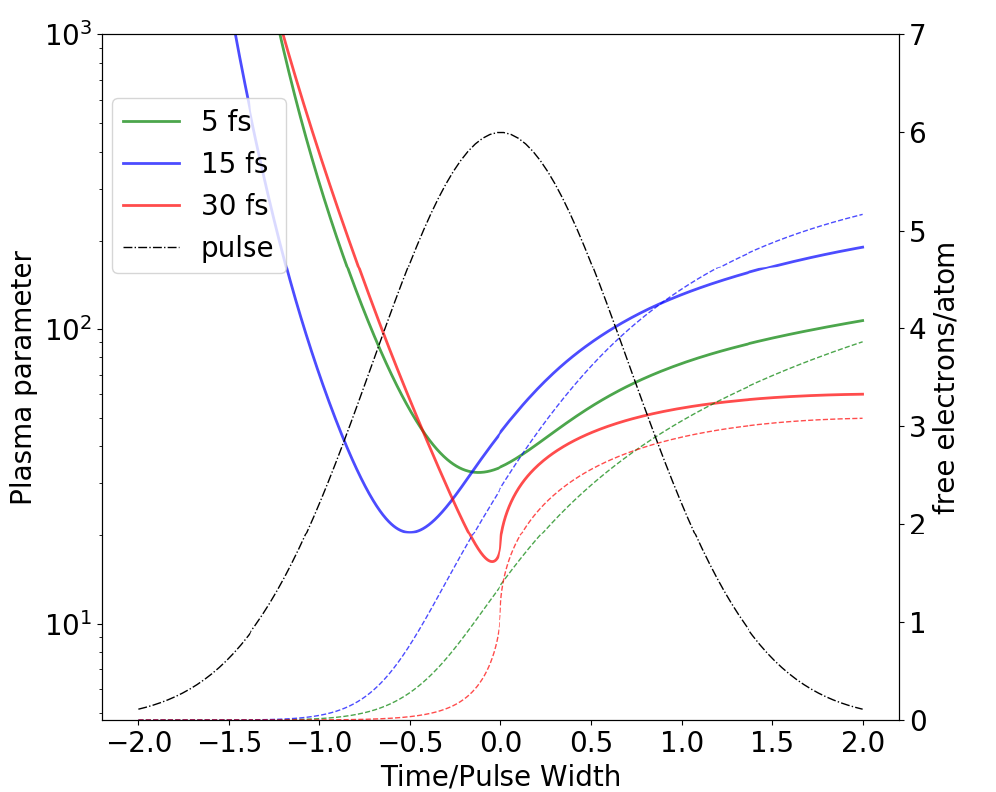
Figure 2. Plasma parameter N D ( t ) = 4 π n e ( t ) λ D ( t ) /3 of the secondary electron plasma in a single unit cell of Lysozyme crystal. An incident XFEL pulses are taken with a FWHM of 5 fs (green), 15 fs (blue), and 30 fs (red). Black line indicates a pulse profile. Solid line indicates a plasma parameter, with a corresponding logarithmic scale depicted on the left. Dashed lines represent a number of free electrons per non-hydrogen atom, depicted in a linear scale on the